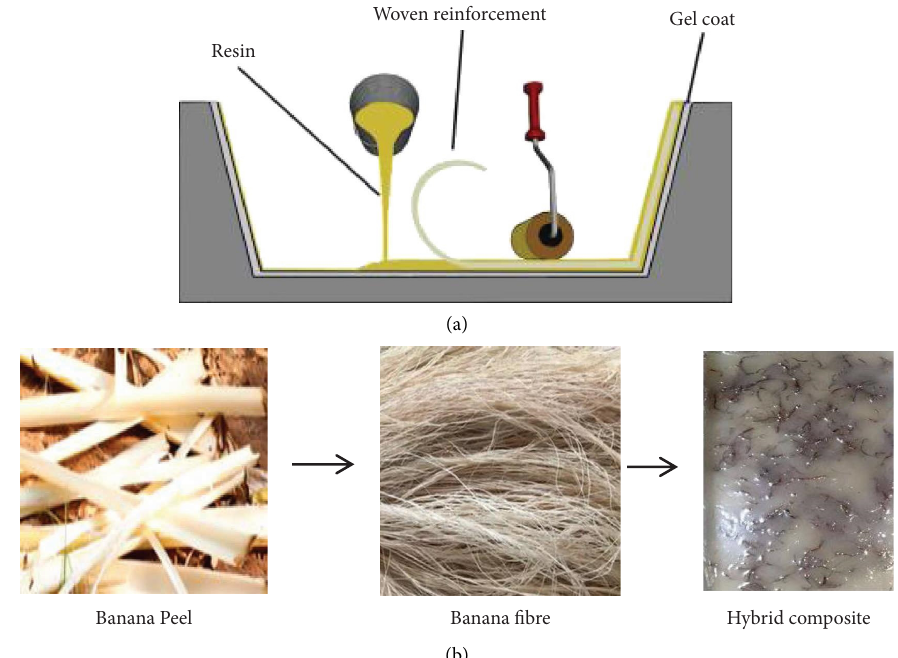
Figure 1: (a) Hand lay-up process fabricated composite. (b) Fabricated